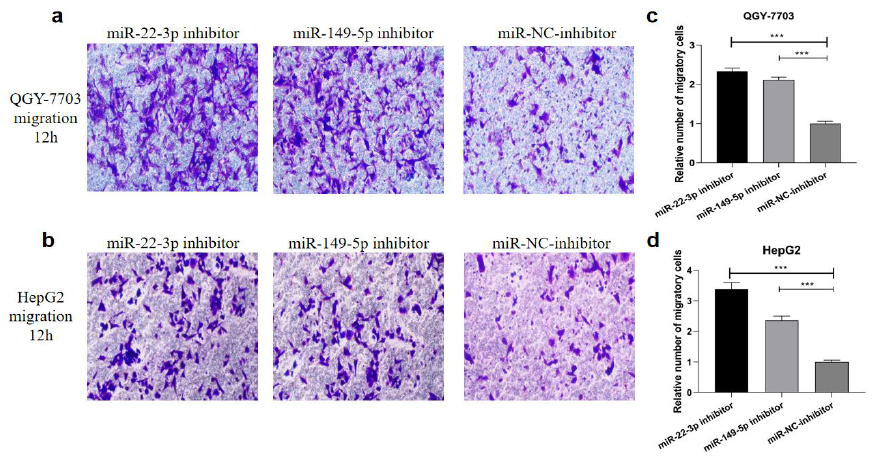
Figure 5. Representative images ( a , c ) and bar graphs ( b , d ) depicting the migration ability of QGY- 7703 and HepG2 after miR-22-3p inhibitor (100 nM), miR-149-5p inhibitor (100 nM), or miR-NC (100 nM) transfection. Data are presented as mean ± S.D. ( n = 6) and analyzed by a two-tailed unpaired t -test (×200 magnification, *** p < 0.001).